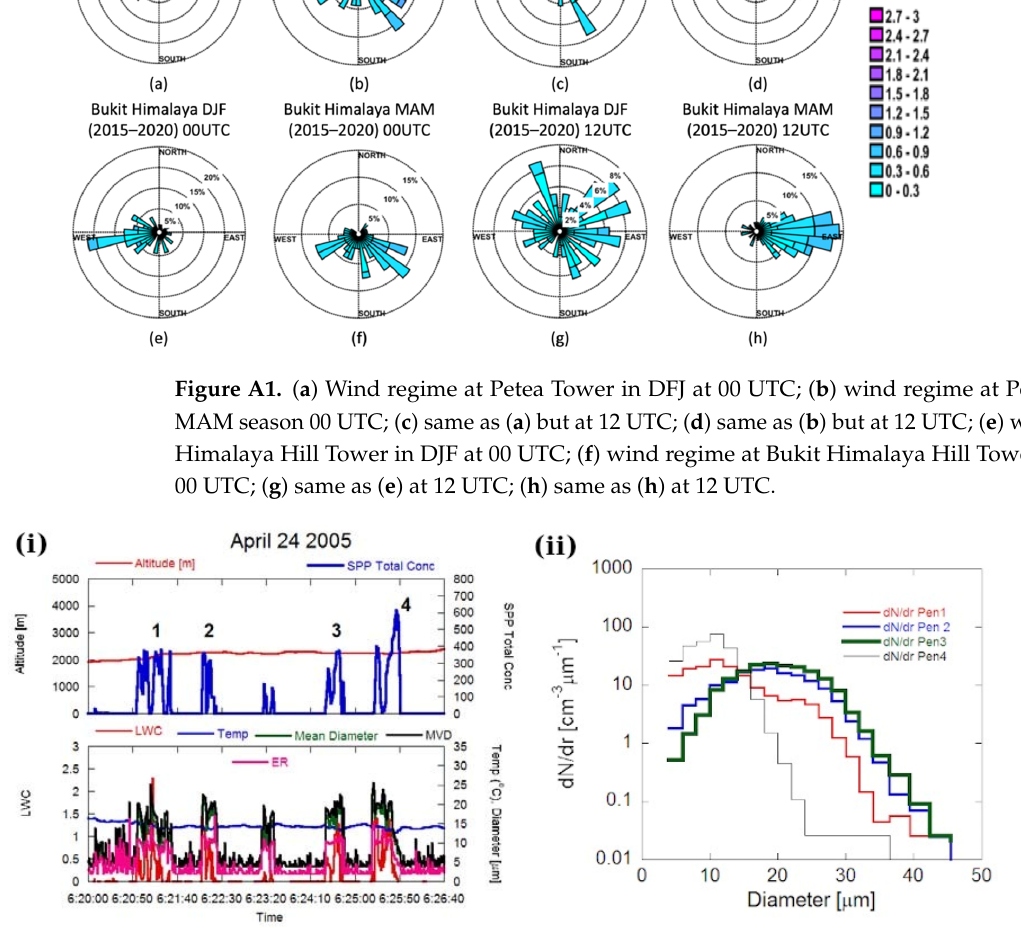
Figure A2. Time history of altitude (m), cloud droplet concentration (cm − 3 ), temperature (C), liquid water content (LWC, gm − 3 ), mean droplet diameter (MD, μ m), mean volume diameter (MVD, μ m), and effective radius (ER, μ m) ( i ); and the droplet size distributions for the four penetrations marked in ( i ), ( ii ) near cloud base at 24 April 2005 (adapted from [18]).